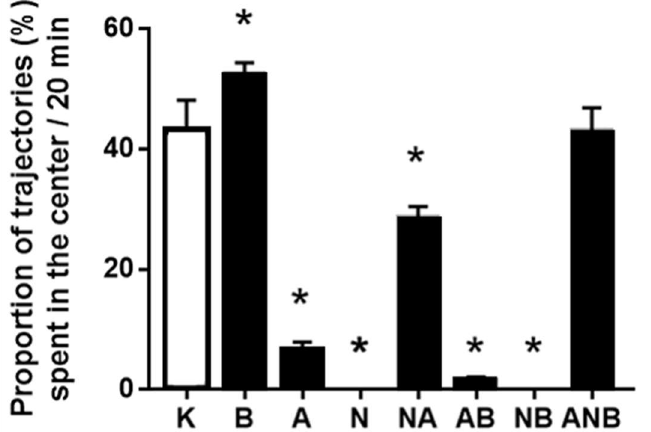
Figure 6. Proportion of trajectories in the center of the open field (%). The proportion of ketamine— induced trajectories in the open field test (OFT), mean values, and 95 percent confidence intervals are shown. In the ketamine rats (30 mg/kg ip), medication (mg/kg ip) was: L-NAME (5) (N), L-arginine (100) (A), BPC 157 (0.01) (B), alone and/or together (L-NAME+L-arginine (NA), L-arginine+BPC 157 (AB), L-NAME+BPC 157 (NB), L-arginine+L-NAME+BPC 157 (ANB)), and saline 5 mL/kg ip (control ketamine) (K). The application was immediately before ketamine (L-NAME, L-arginine, and combination) or the application was immediately after ketamine (BPC 157 and combinations). Dunnett’s multiple comparison test was used to compare control group (K) with treated groups. * p < 0.001 relative to ketamine.